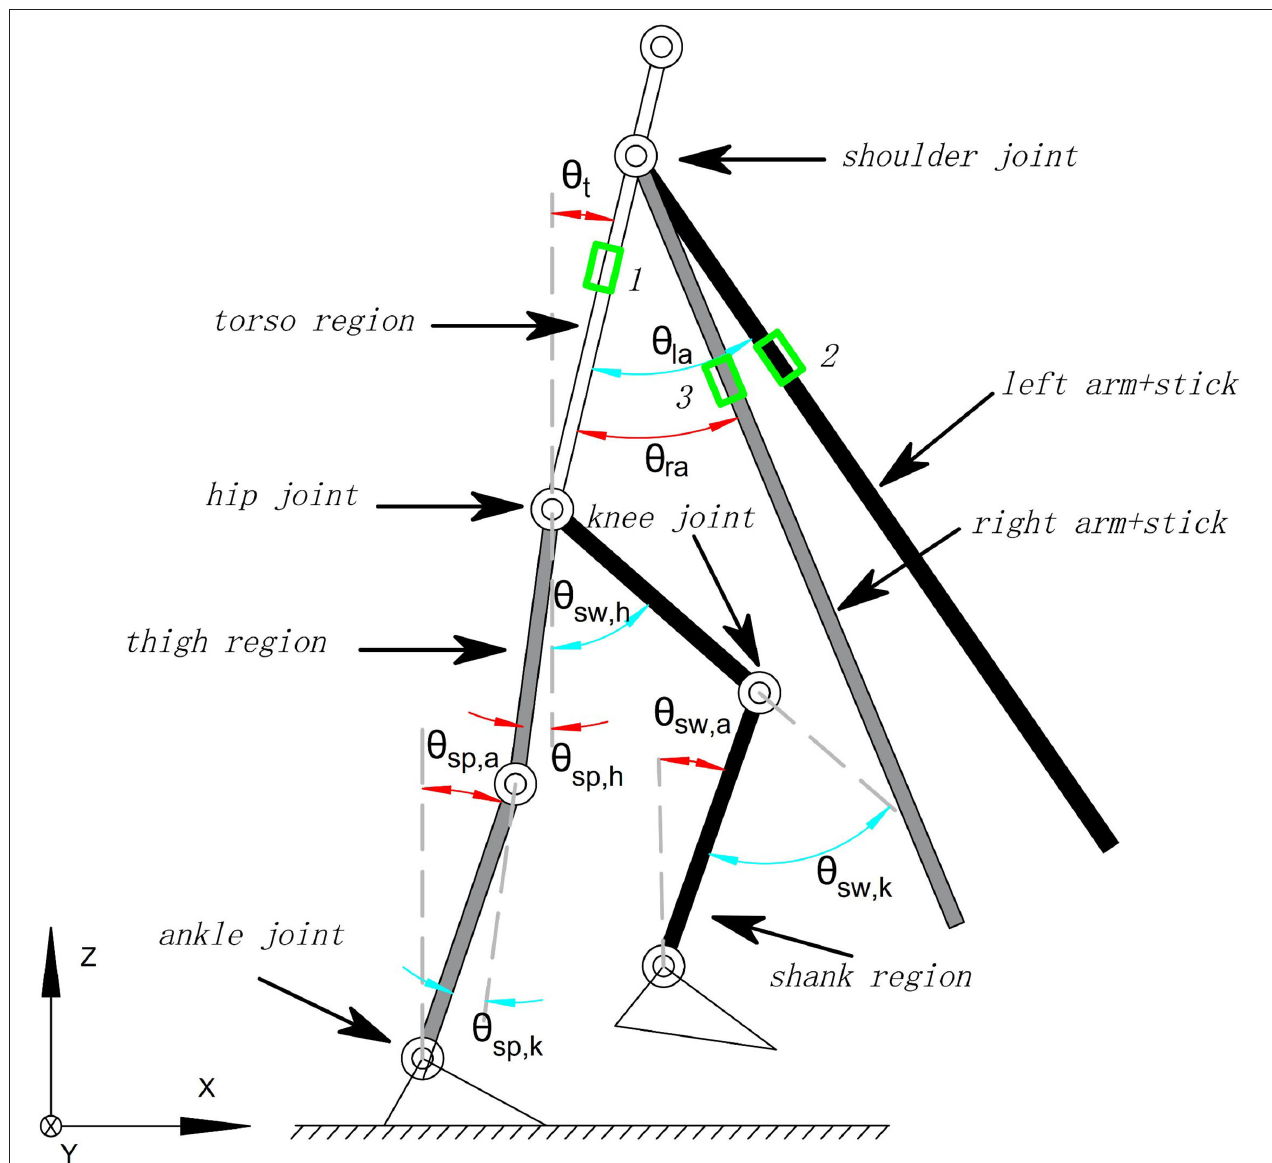
FIGURE 12 | Human-exoskeleton model with sticks. It consists of the torso, arms, legs, and feet, which are linked by shoulder joints, hip joints, knee joints, and ankle joints. The human arms connected to the sticks are defined as left arm+stick and right arm+stick, respectively. The joint angles of lower limbs are defined in the model: the hip angles of support leg and swing leg θ sp , h , θ sw , h , the knee joint angles of support leg and swing leg θ sp , k , θ sw , k , and the ankle joint angles of support leg and swing leg θ sp , a , θ sw , a . They are measured by the encoders installed on the joints of the exoskeleton. Additionally, the upper limbs’ joint angles are defined: the torso inclination angle θ t , the shoulder angles corresponding to the movements of the arms and sticks of left and right in the x-axis direction are θ lax and θ rax . In contrast, the shoulder angles resulted from the movements in the y-axis direction are θ lay and θ ray . Also, the length of the regions are defined as follows: l to : the length of torso, l as : the length of left/right arm and stick, l th : the length of the thigh, l sh : the length of the shank, and h f : the height of the foot. The IMUs are installed at the torso, the arms and sticks of left and right labeled 1,2,3, and the length from label 1 to the hip joint is defined as l com